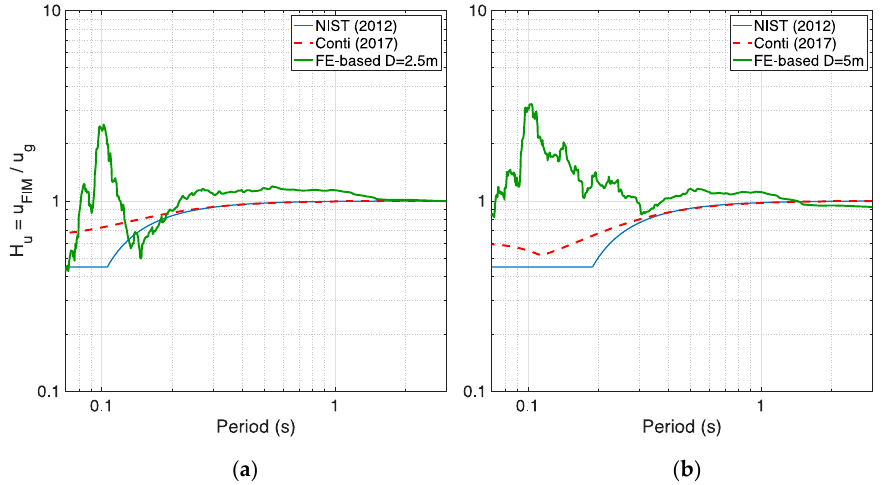
Figure 17. Comparison between surface free-field motion and signals at basement level (two different depths) for BOWW soil profile and record “Accel outcrop” in terms of acceleration ( a ) histories and ( b ) response spectra.